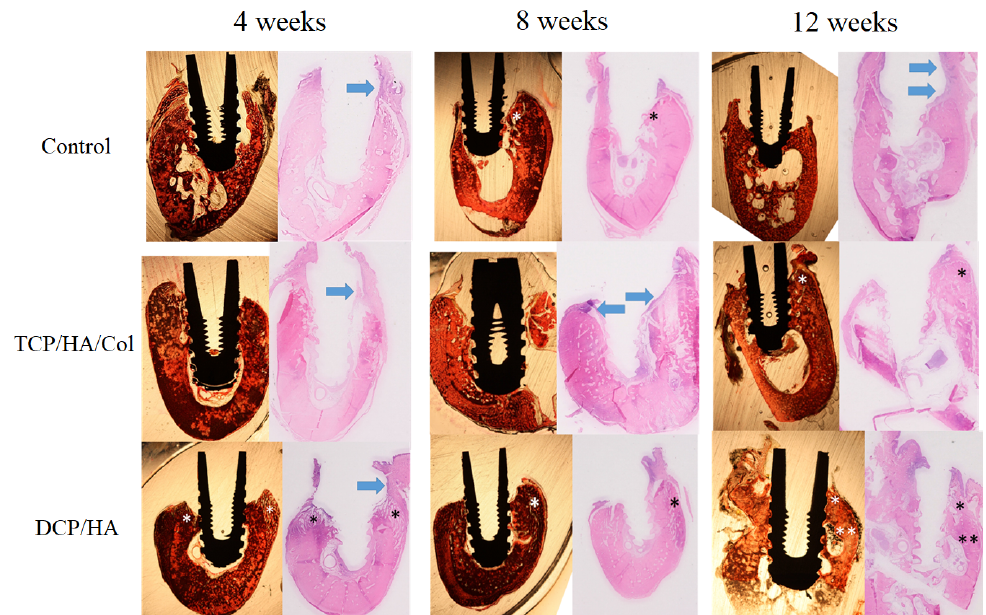
Figure 4. Ground and decalcified sections of the dental implant and surrounding bone. In the control group, marginal bone loss (MBL) was observable at 4 weeks. Prominent inflammation (arrow) that contributed to MBL was observed in the decalcified section in the control group. Although MBL was observed, some woven bone formation below the periosteum was identified 8 weeks after the operation (*). At 12 weeks after surgery, marked inflammation (arrow in decalcified section) causing severe MBL was also observed. In the TCP/HA/Col group, inflammation around the implant and some remaining graft material were observed at 4 and 8 weeks (arrow). At 8 weeks, new immature bone formation was observed. Furthermore, at 12 weeks, more marginal alveolar bone formation (*) was observed than at previous time points. No discernable residual graft material was identified at 12 weeks. In the DCP/HA group, prominent woven bone formation (*) was observed at 4 weeks; however, moderate inflammation was also observed (arrow). DCP/HA graft material could not be easily identified at 4 weeks. At 8 weeks, the DCP/HA group exhibited highly mature bone formation surrounding the dental implant (*), compared with the other two groups. In addition, soft tissue inflammation also decreased without discernable graft material. At 12 weeks, higher levels of formation of woven bone (*) at the top of the marginal bone and mature compact lamellar bone (**) around the dental implant were observed, compared with the other two